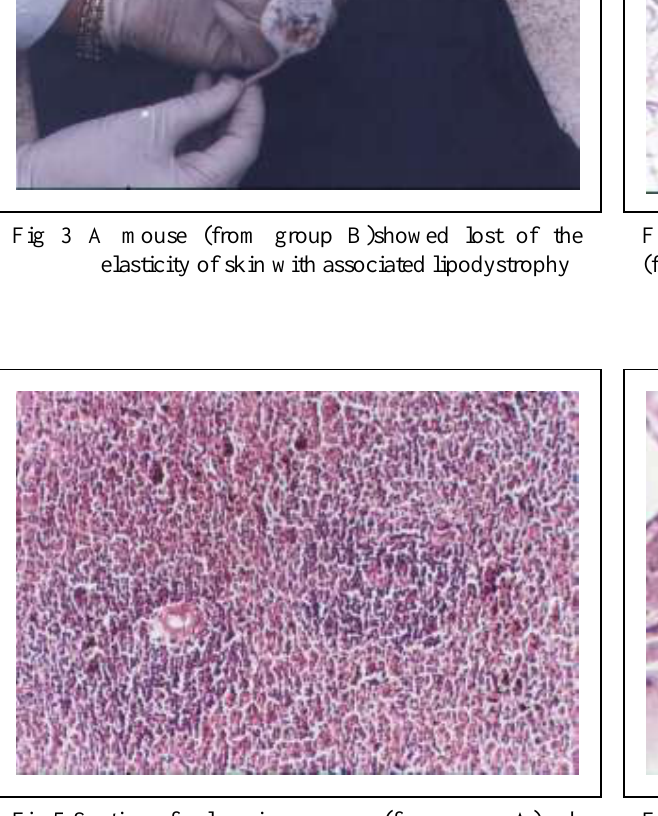
Fig 6 Section of kidney in a mouse (from group B) sub group I showed glomerular deposit of amyloid with cortical tubular dilation (H and E X